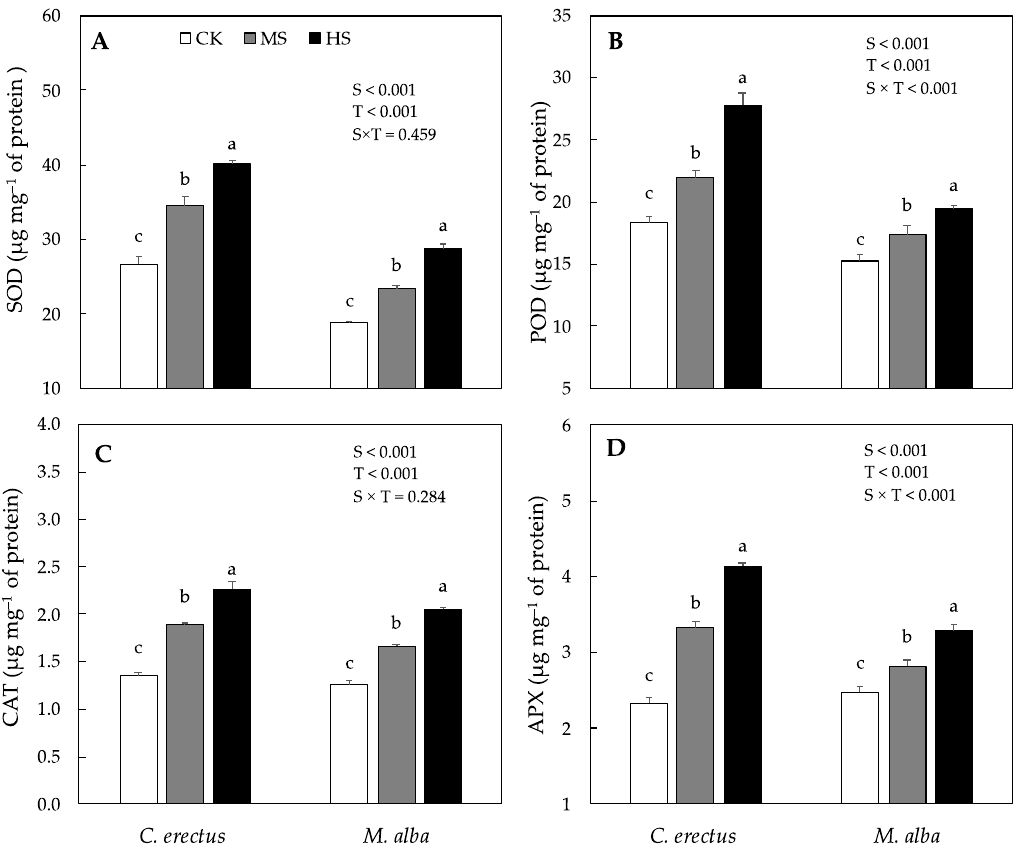
Figure 4. Mean activity various antioxidants enzyme concentration ( A ) superoxide dismutase, SOD, ( B ) peroxidase, POD, ( C ) catalase, CAT and ( D ) ascorbate peroxidase, APX under control (CK), Medium (MS) and high (HS) water deficit treatments in C. erectus and M. alba . All the attributes were tested using a two-way ANOVA for species effect (S-effect), treatment (T-effect) and interaction (S × T) effects. All values represent the means ( ± SE) of species in various combinations. Small letters set in bold represent a significant difference within each species tested using Dunnett’s test. All the tests were taken significant at p < 0.005.